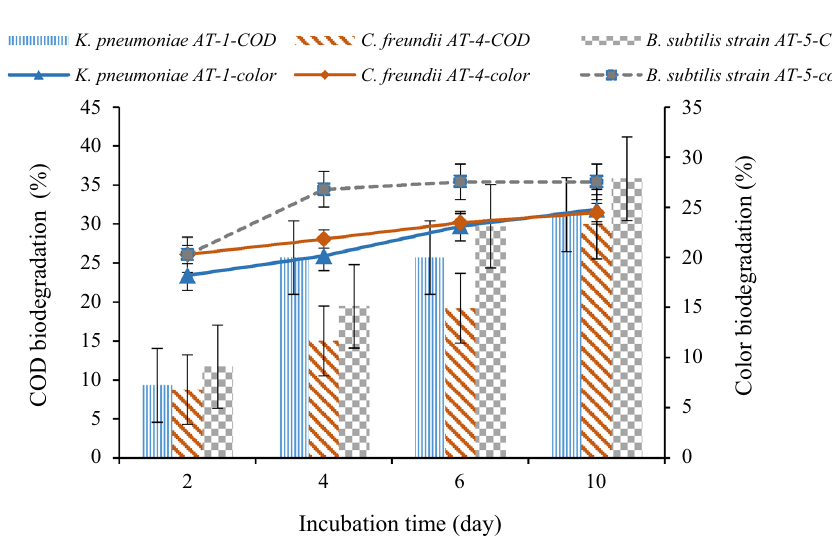
Figure 6. COD and color biodegradation rate by K. pneumoniae AT-1, C. freundii AT-4, and B. subtilis AT-5 during the incubation period (effluent +